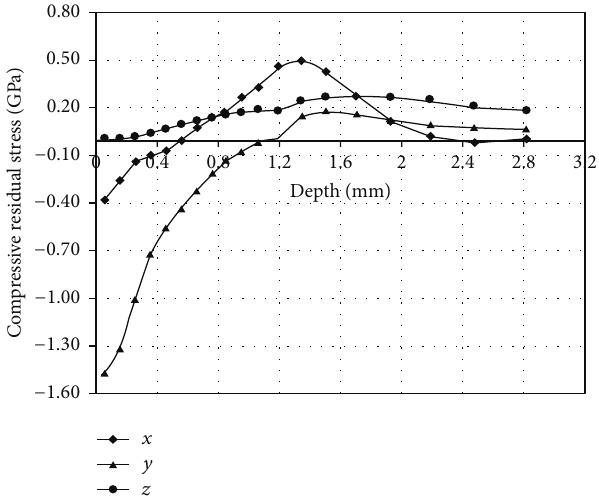
Figure 10: The model of deep rolling (not scaled) used in the simulations